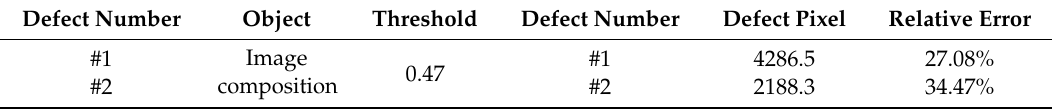
Table 1. Statistics of defect parameters on image composition processing.